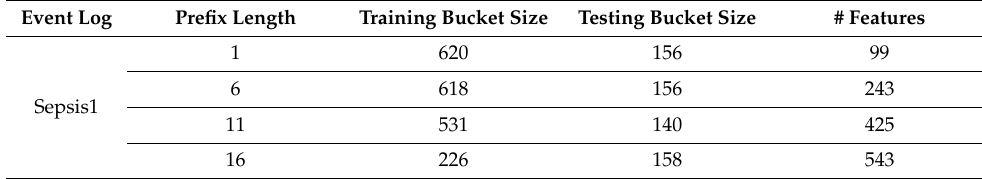
Table 6. Statistics after applying prefix-index to the event